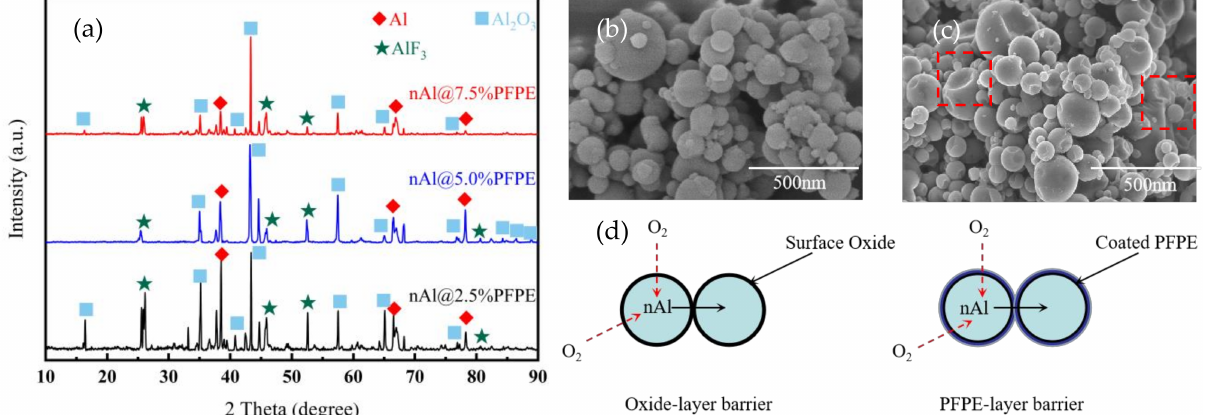
Figure 8. ( a ) X-ray diffraction patterns of the oxidized PFPE-functionalized Al NPs; SEM photos of ( b ) the initial and ( c ) the oxidized PFPE-functionalized Al NPs; ( d ) oxidation paths of PFPE- functionalized Al NPs compared with